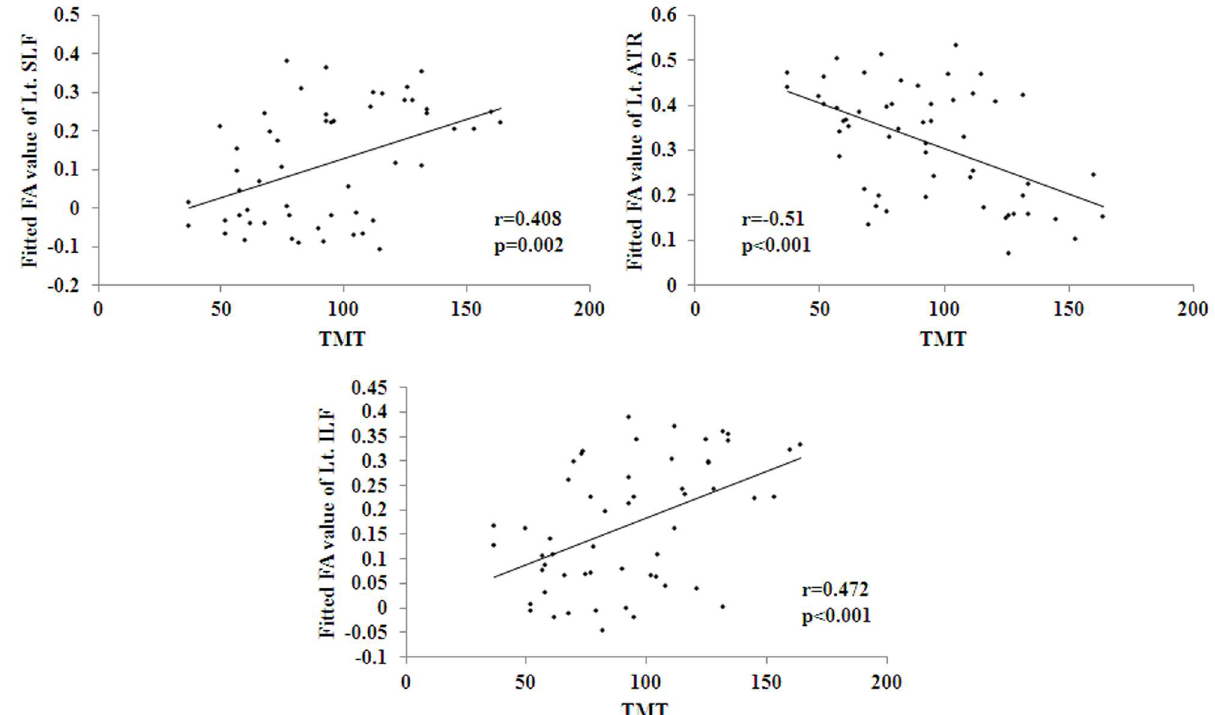
Fig 4. Significant correlations between FA values and TMT scaleswere found to be negative in Lt. ATR, and positive in Lt. SLF and Lt. ILF. TMT: the trail making